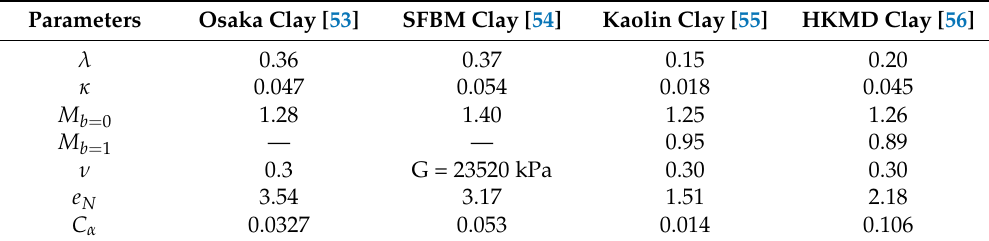
Table 3. Model parameters.